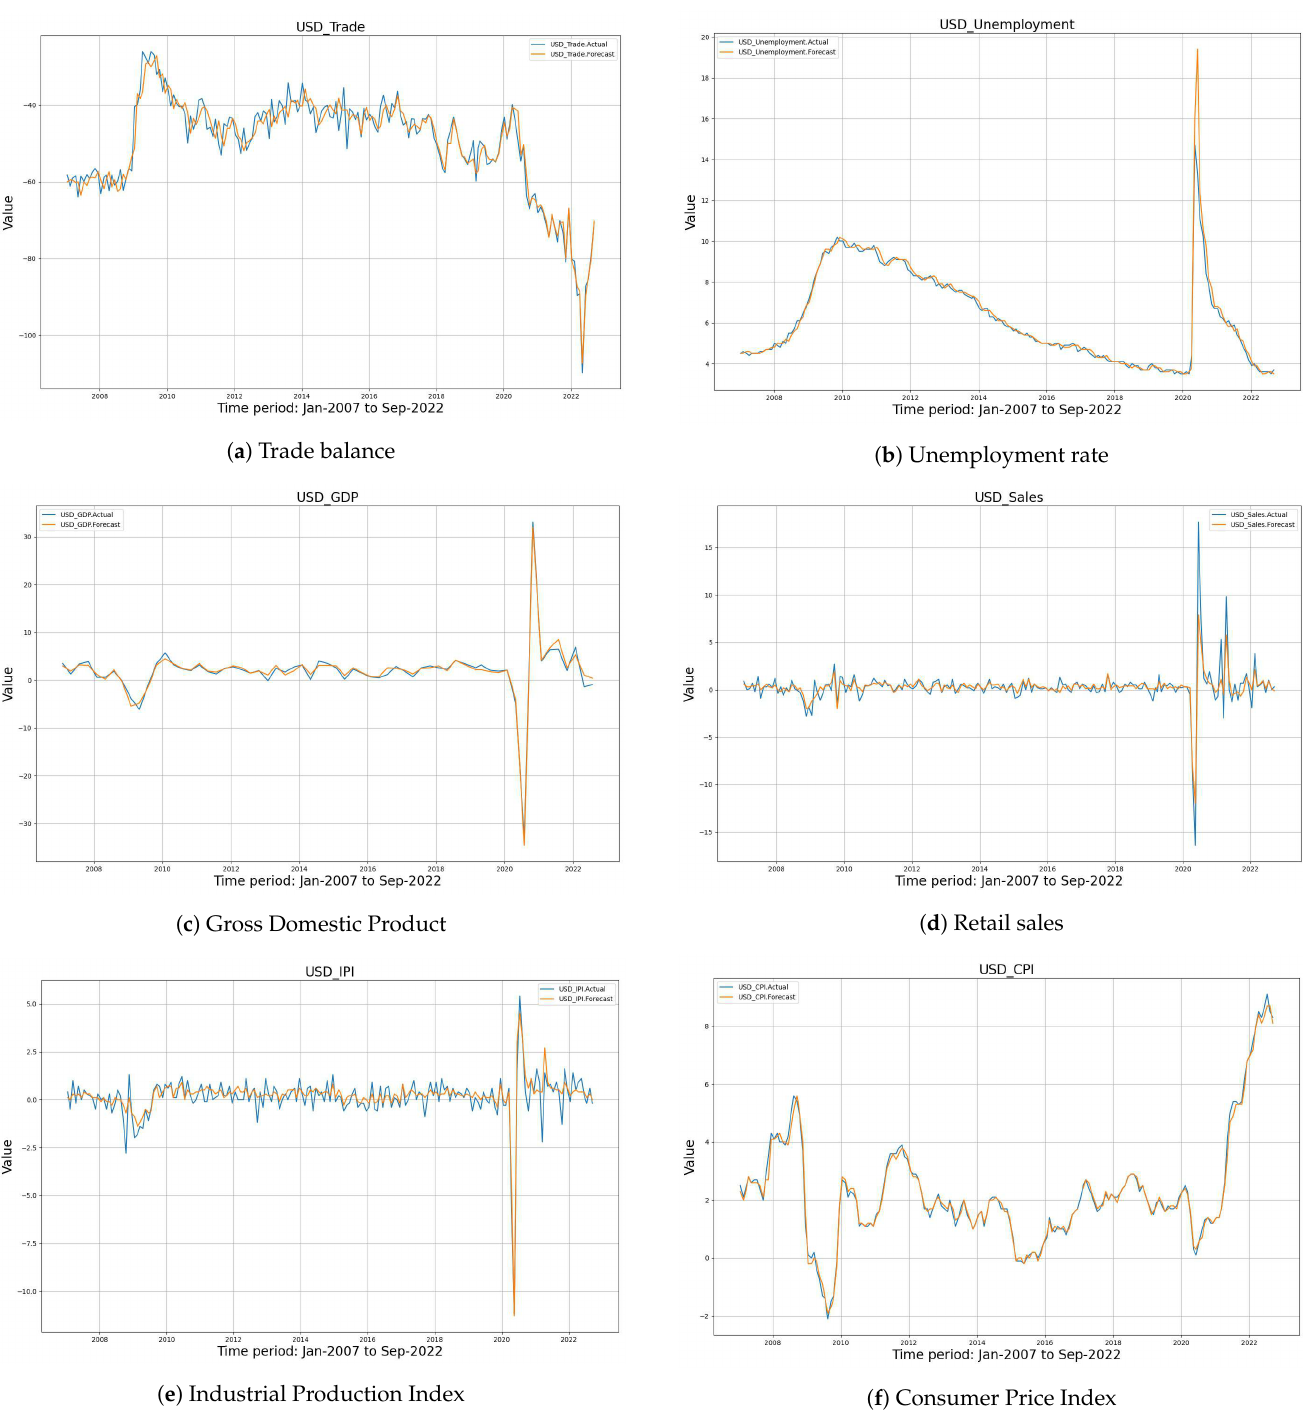
Figure 1. Plot showing the time evolution of the 6 macroeconomic news items from the United States (USA) for the time period analysed between June 2007 and September 2022. The current value of each time period is marked in blue, and the predicted value in